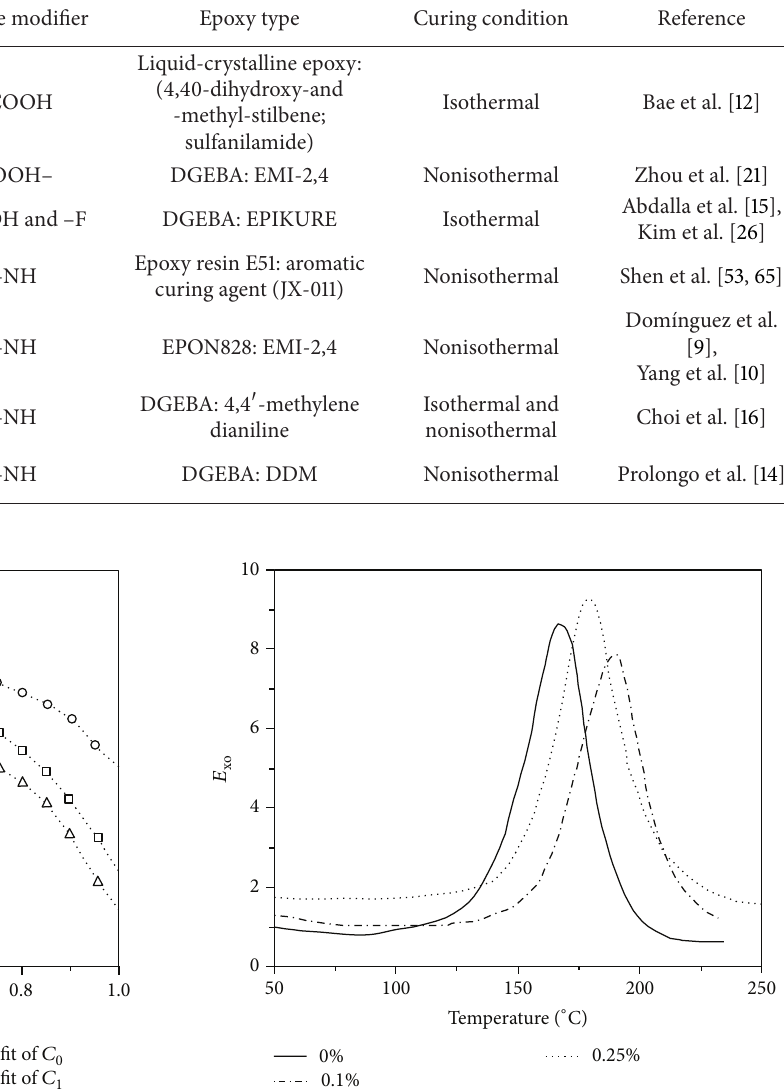
Table 1: The effect of functionalization of MWCNTs on cure kinetics of epoxy systems.